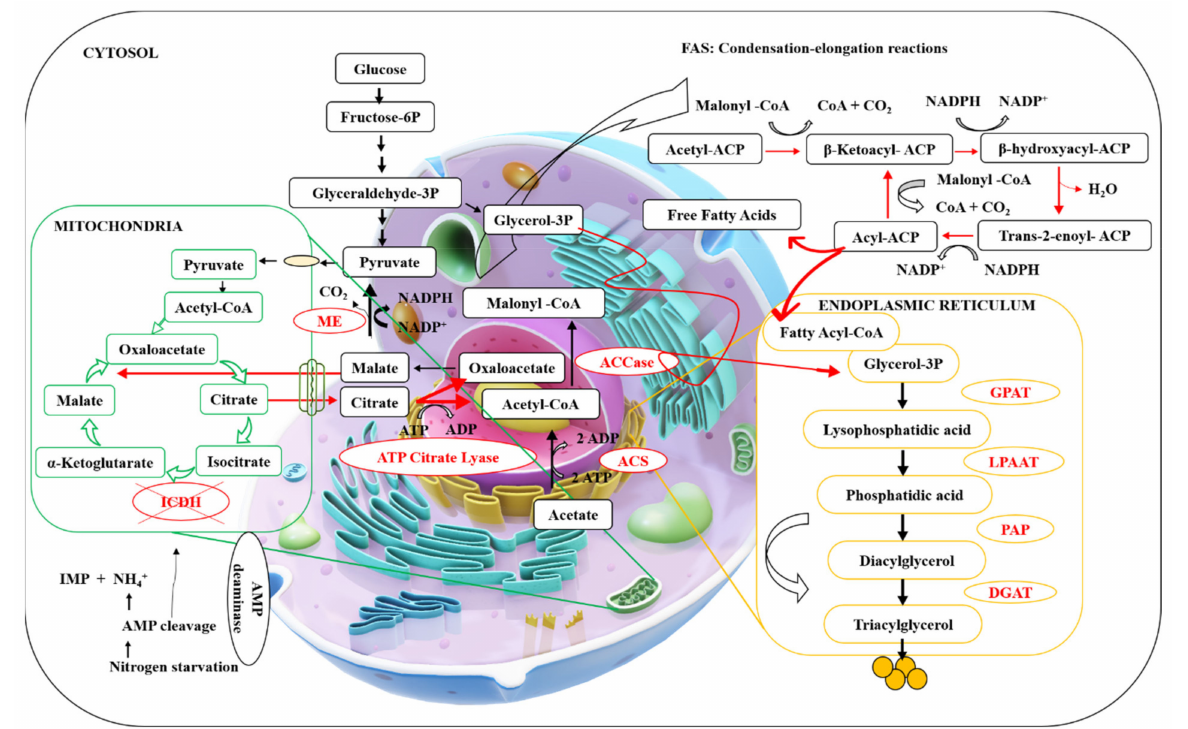
Figure 1. Biochemistry of triglycerides (TAG) accumulation in oleaginous yeasts. Key enzymes in triglyceride synthesis are highlighted with red circles. Mitochondrial pathway in green, endoplasmic reticulum pathway in yellow and cytosolic path- way in black. Abbreviations: fatty acid synthase (FAS), isocitrate dehydrogenase (ICDH), malic enzyme (ME), acetyl-CoA carboxylase (ACCase), acetyl-CoA synthetase (ACS), glycerol-3-phosphate acyltransferase (GPAT), lysophosphatidic acid acyltransferase (LPAAT), phosphatidate phosphatase (PAP), diacylglycerol acyltransferase (DGAT). Adapted from